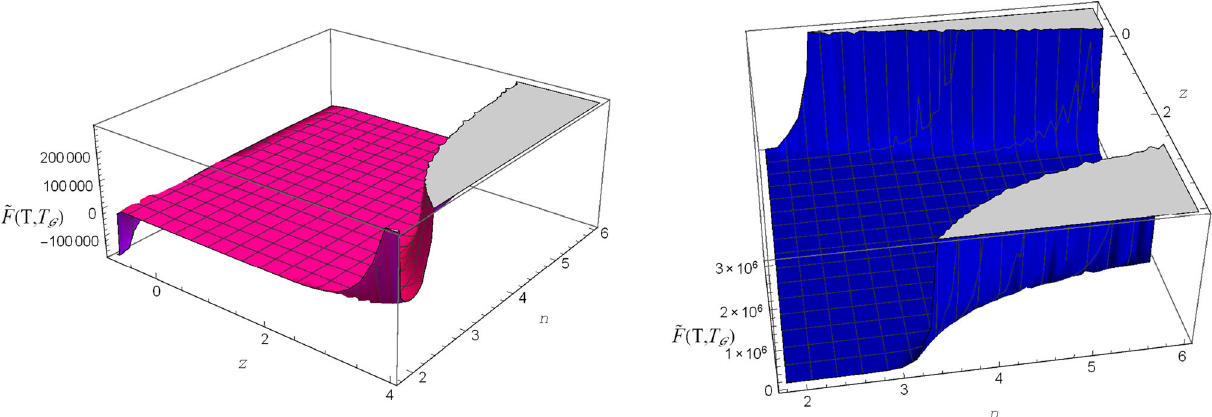
Fig. 1 Plots of power-law reconstructed GGPDE ˜ F ( T , T G ) model for u = 2 (left) and − 2 (right)